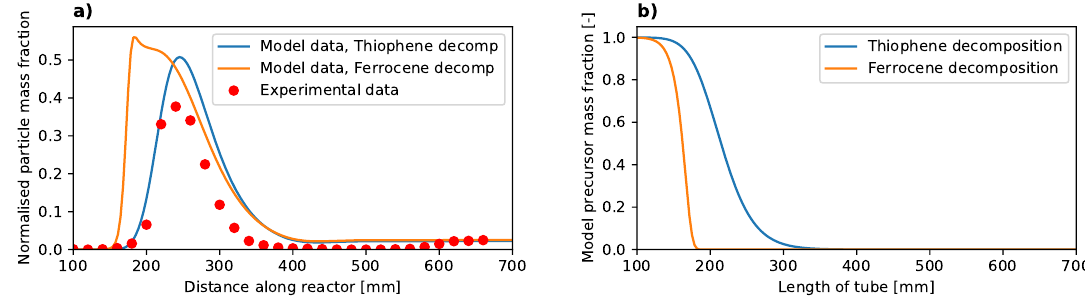
Figure 12. Comparison of thiophene (blue) and ferrocene (orange) decomposition rates, with experimental data from Hoecker et al. [9]: ( a ) the mass fraction evolution; and ( b ) the decomposition of the source using the different decomposition